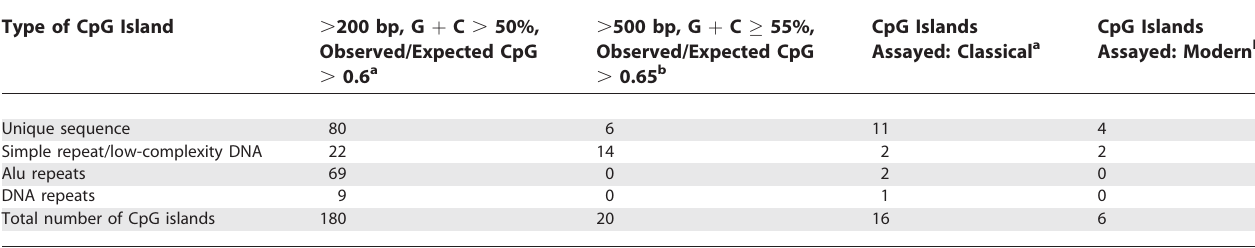
Table 1. CpG Islands across the 6.76-Mbp 10q25 Region Analyzed Type of CpG